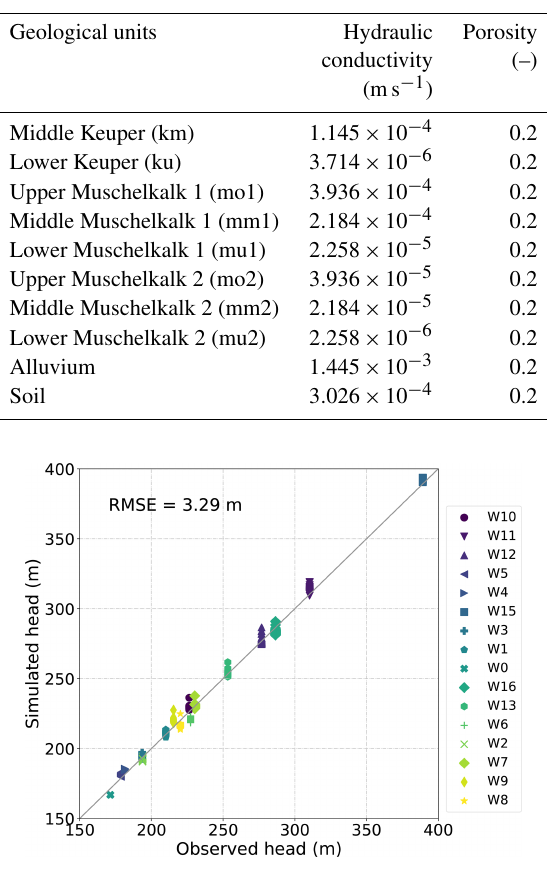
Table 2. Hydraulic parameters used for ensemble simulations with different climate scenarios.